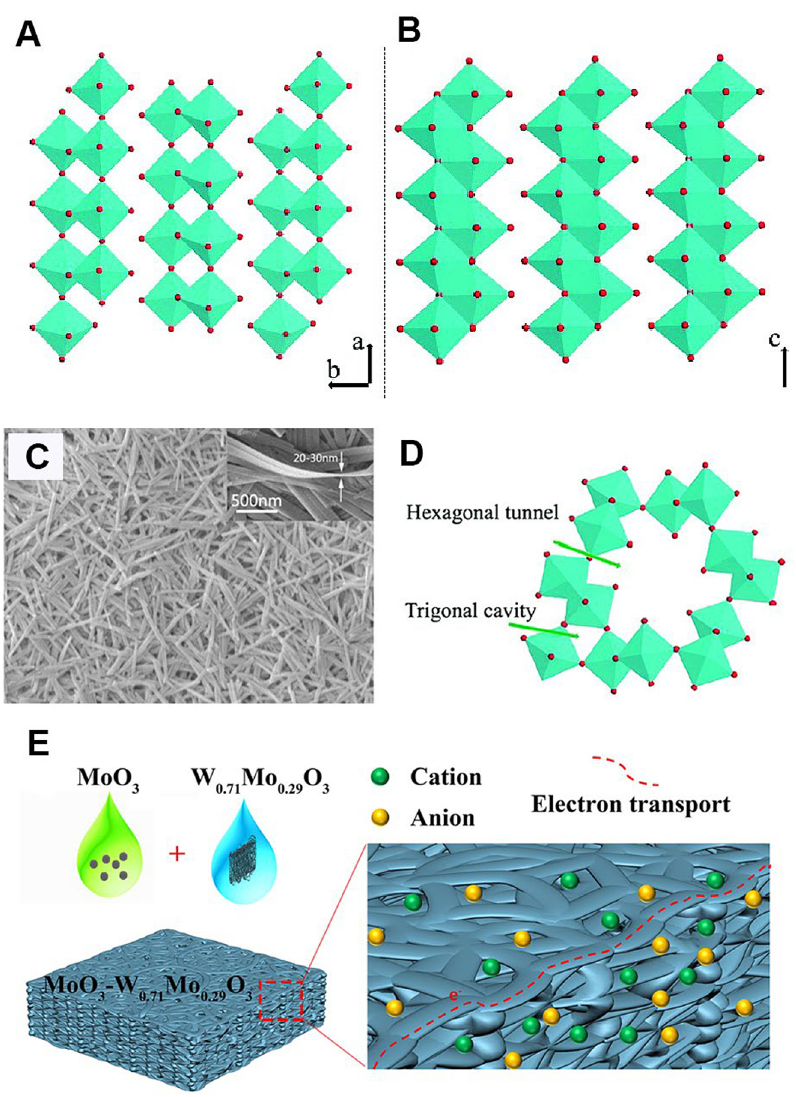
MoO duringtheintercalation/deintercalationofguestions,but 3 (Figure9C)[161].Theopenchannelstructureofthehexagonal alsoprovidesnumerouschargetransportpathwaystoenhance MoO transport kinetics. Notably, the MoO nanobelts favors the ef fi cient insertion of the guest ions -W Mo O nano- 3 3 0.71 0.29 3 (Figure 9D). As such, the MoO hybrid fi lmsshowimprovedcyclingstabilitycomparedwiththe nanobelt fi lms exhibit a more 3 fi lms. fi lms. intrinsic MoO stable cycling performance than orthorhombic α -MoO 3 3 Moreover, the nanohybridization of molybdenum oxide nanoparticles with tungsten molybdenum oxide nanowires 4.3 Titanium oxides offers an interesting electrochromic material platform as it circumvents many of the issues inherent to MoO (e.g., slow 3 ionic transportation ef fi ciency and volume expansion during Titanium oxides (e.g., titanium oxide, hydrated titanium cycling) [25]. Through a solution-processed method, MoO oxide, and doped titanium oxide) have been recognized as 3 one of the most promising electrode materials for semi- nanocrystalswereembeddedinthenanoporesofW Mo O 0.71 0.29 3 conductor electrochemistry [163]. Naturally, bulk titanium fi lm(Figure9E).TheW oxide exists in three crystalline phases: rutile, anatase, and Mo O nanowiresnotonlyserveas 0.71 0.29 3 brookite [164].Refer tothe crystal structureof titanium oxide, abuffermatrixwhicheliminatesthelarge-volumeexpansionof